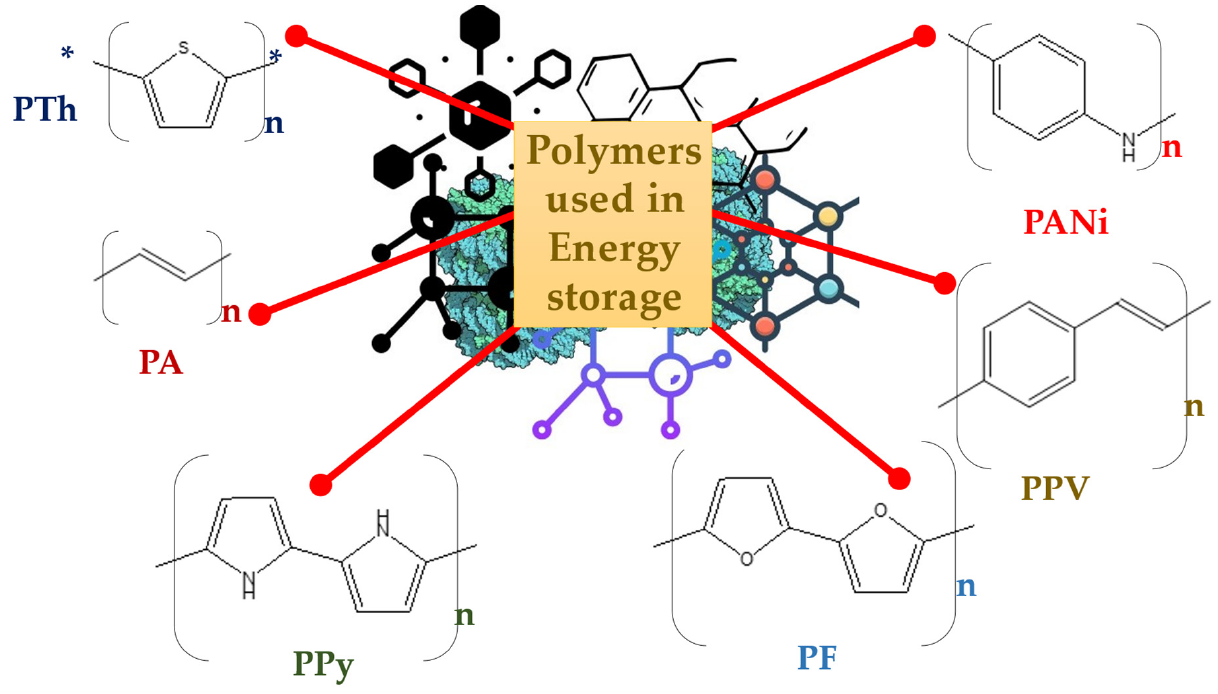
Figure 3. Structures of polymers that are commonly associates with carbon allotropes for energy